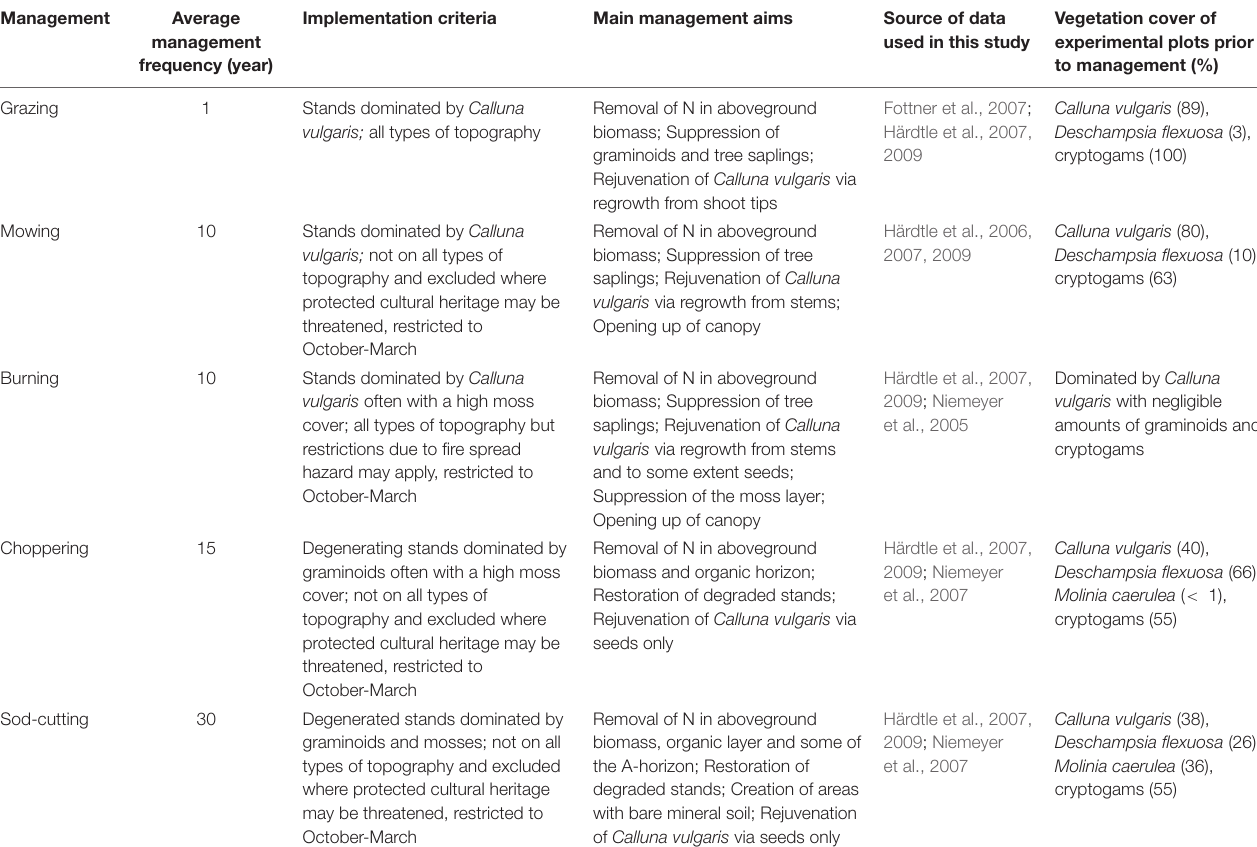
TABLE 1 | Overview of management practices and the experimental